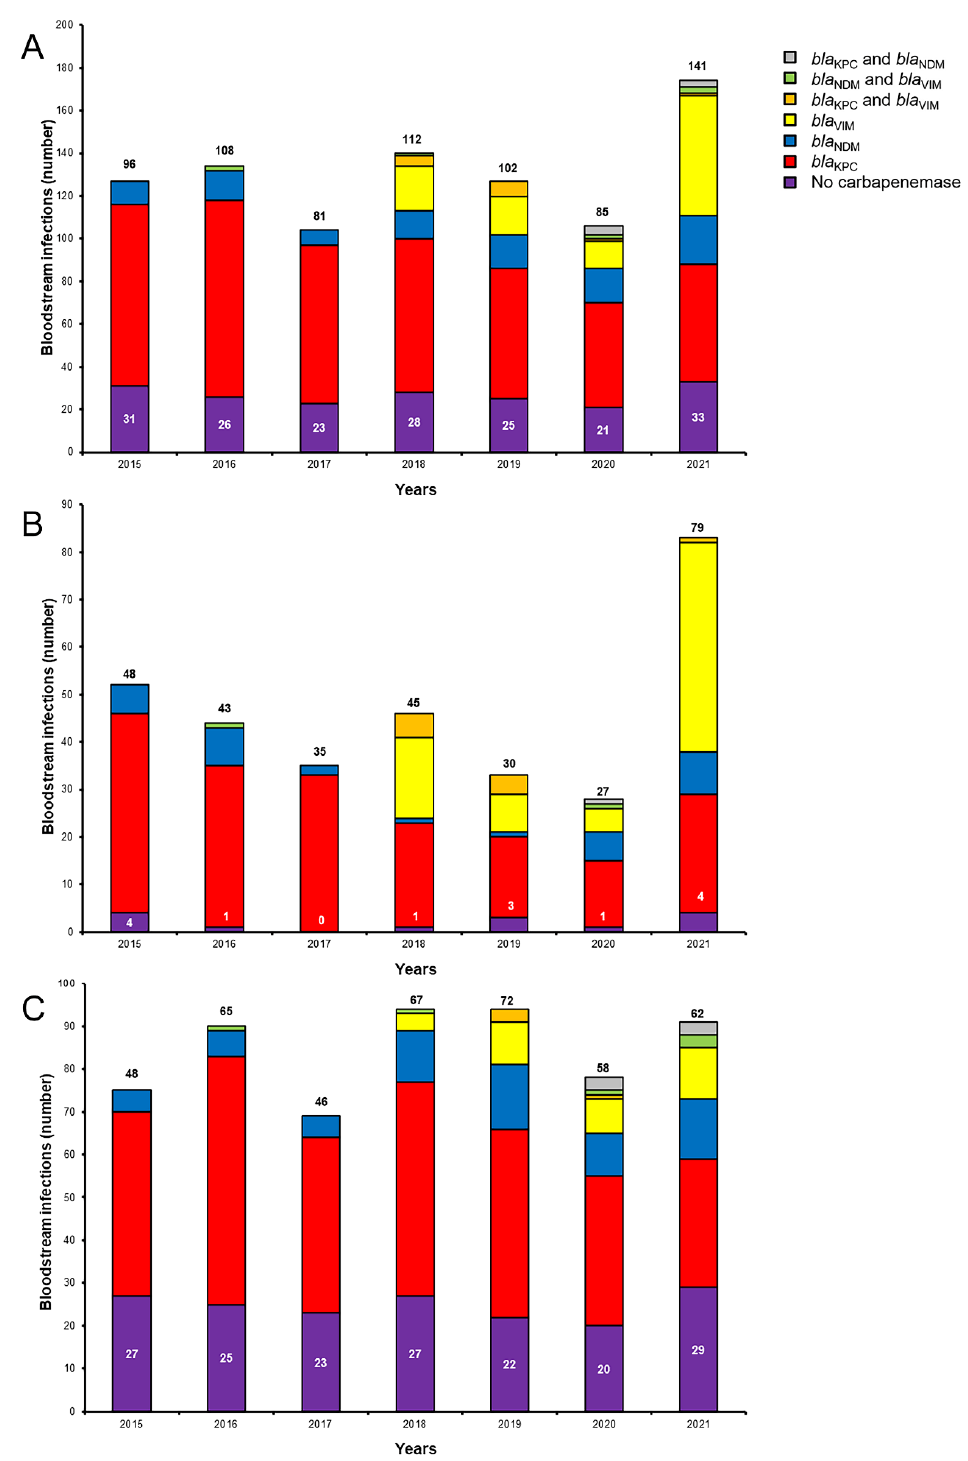
Figure 1. Annual episodes of K. pneumoniae BSIs according to carbapenemase genes; ( A ): all wards; ( B ): ICU; ( C ): non-ICU wards. White numbers: episodes of BSIs due to carbapenem-susceptible K. pneumoniae ; black numbers: episodes of BSIs due to carbapenem-resistant K. pneumoniae. Among CP-Kp, BSIs due to KPC-producing isolates decreased over time from 88.5% in 2015 to 39.0% in 2021 (Figure 1), reflecting a statistically significant decrease in